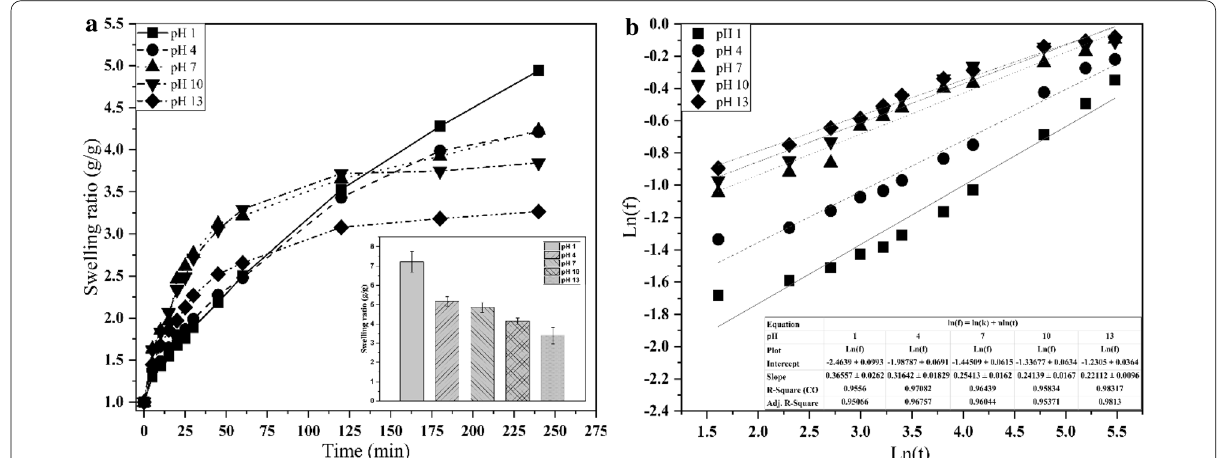
Fig. 3 Swelling ratios of the 50/50 CS/PVA hydrogel discs at a pH 1–13, b ln( f ) vs. ln( t ) plot